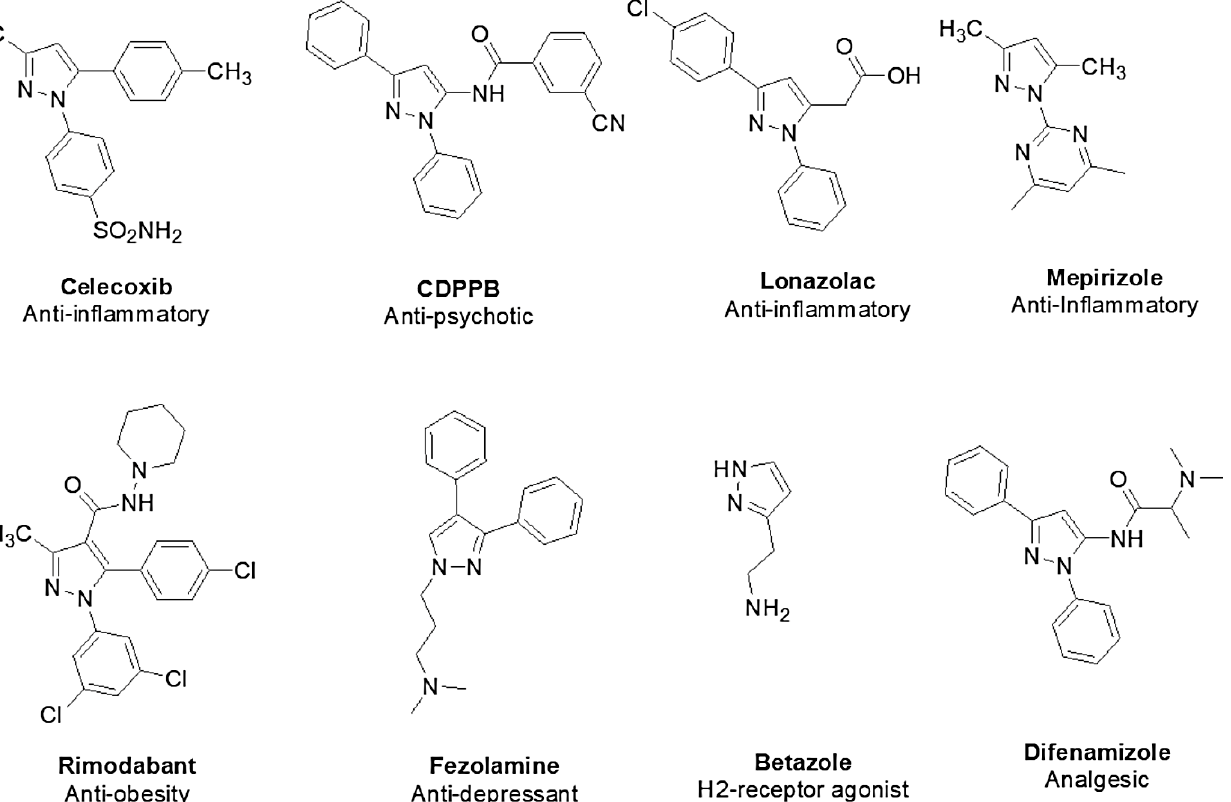
atives, including 2-(4-bromo-3,5-diphenyl-pyrazol-1-yl)-ethanol (BBB4, Figure 2), showed anti-inflammatory, local anaesthetic, and motor activity inhibition effects in mice and rats, while showing mild platelet antiaggregating action in vitro [5].